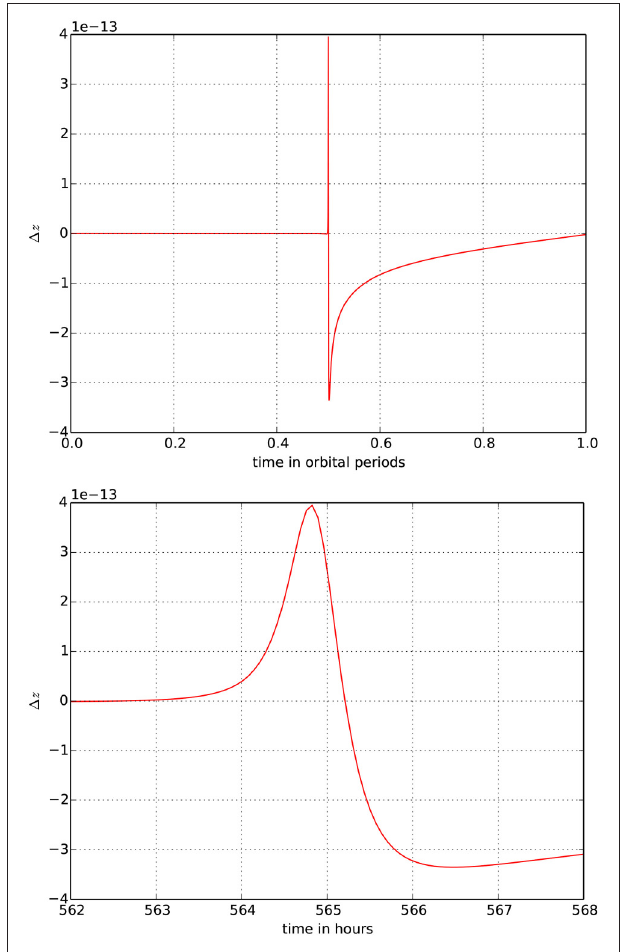
FIGURE 3 | (Upper) contribution to the redshift from frame-dragging by Jupiter’s spin, for the same orbit as in Figure 2 . The signal peaks at the orbit pericenter passage. (Lower) zoom into pericenter passage.